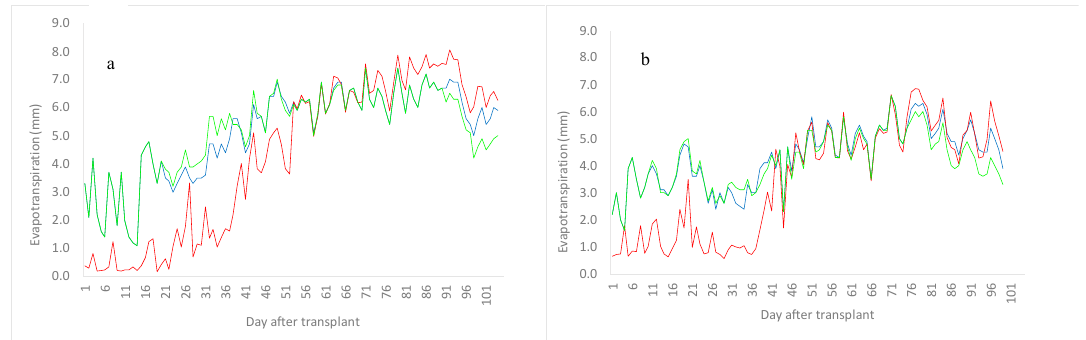
Figure 6. Crop evapotranspiration estimated by AquaCrop (blue), IRRISAT (red) and direct insertion (green) of fc retrieved by Sentinel-2 imagery into AquaCrop, in 2017 ( a ) and 2018 ( b ). The agreement between AquaCrop and IRRISAT ETp estimates is excellent in the mid-season stage, between about the 50th and 85th day after transplant, when the crop canopy is fully developed.